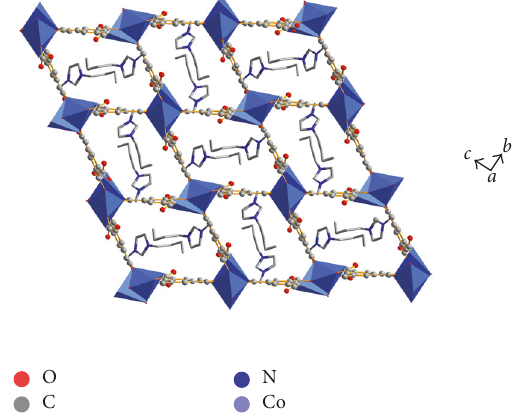
Figure 2: The 3D framework of [BMI] 2 [Co 2 (BTC) 2 (H 2 O) 2